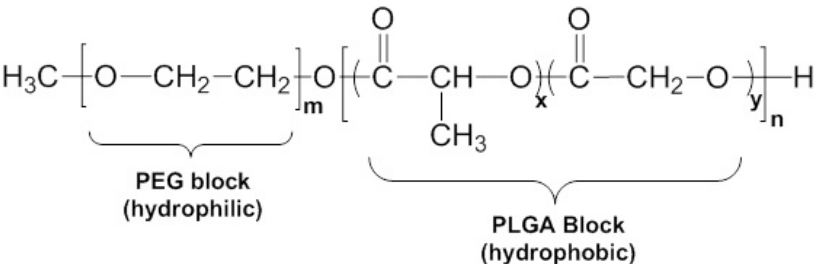
Figure 2. Structure of PLGA-b-PEG used for encapsulation of ZnPcBCH 3 , where n = 11,500, m = 2000, x = y. x =